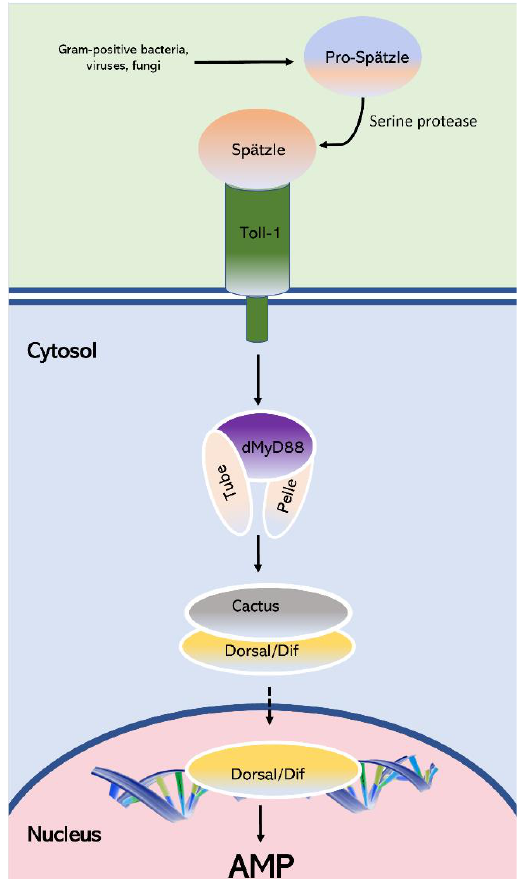
Figure 9. A schematic representation of Toll signaling system in D. citri . The model highlights the Toll signaling pathway as it functions during the immune response. The pattern recognition receptors recognize pathogens and activate a serin protease cascade and cause a binding of Speatzle to Toll. Toll binds to Myd88 through TIR domains and induces Myd88 to bind to Tube and Pelle through their death domains and make a triangle. The bindings lead to the recruitment of two proteins, the adaptor Tube and kinases Pelle. This results in the proteolytic degradation of the inhibitor kB (IkB) protein Cactus and activation of the NF-kB proteins Dif and Dorsal (same protein in D. citri ). The activated Dorsal/Dif is translocated to the nucleus and induces the transcription and production of antimicrobial peptides